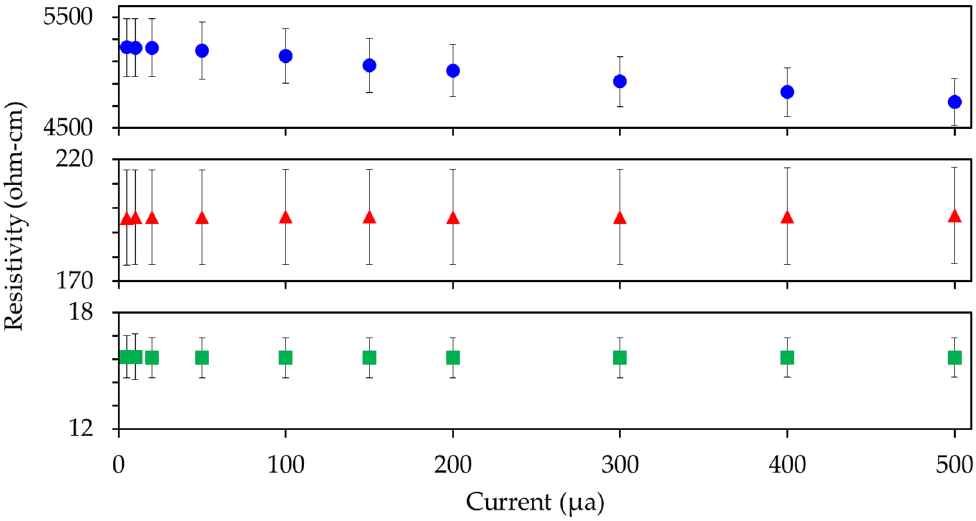
Figure 11. Electrical resistivity as a function of applied current for composites made with 0.75 wt% CNTs at different phases of the preparing and Eu:Y 2 O 3 synthesis process.